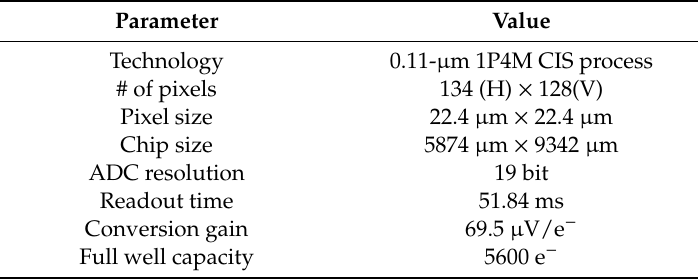
Figure 7. Chip micrograph. CDS: correlated double sampling, FI/C-ADC: Folding-Integration/Cyclic ADC, LEFM: lateral electric field charge modulation. Table 1. Brief summary of the prototype CMOS imager performance. CIS: CMOS image sensor